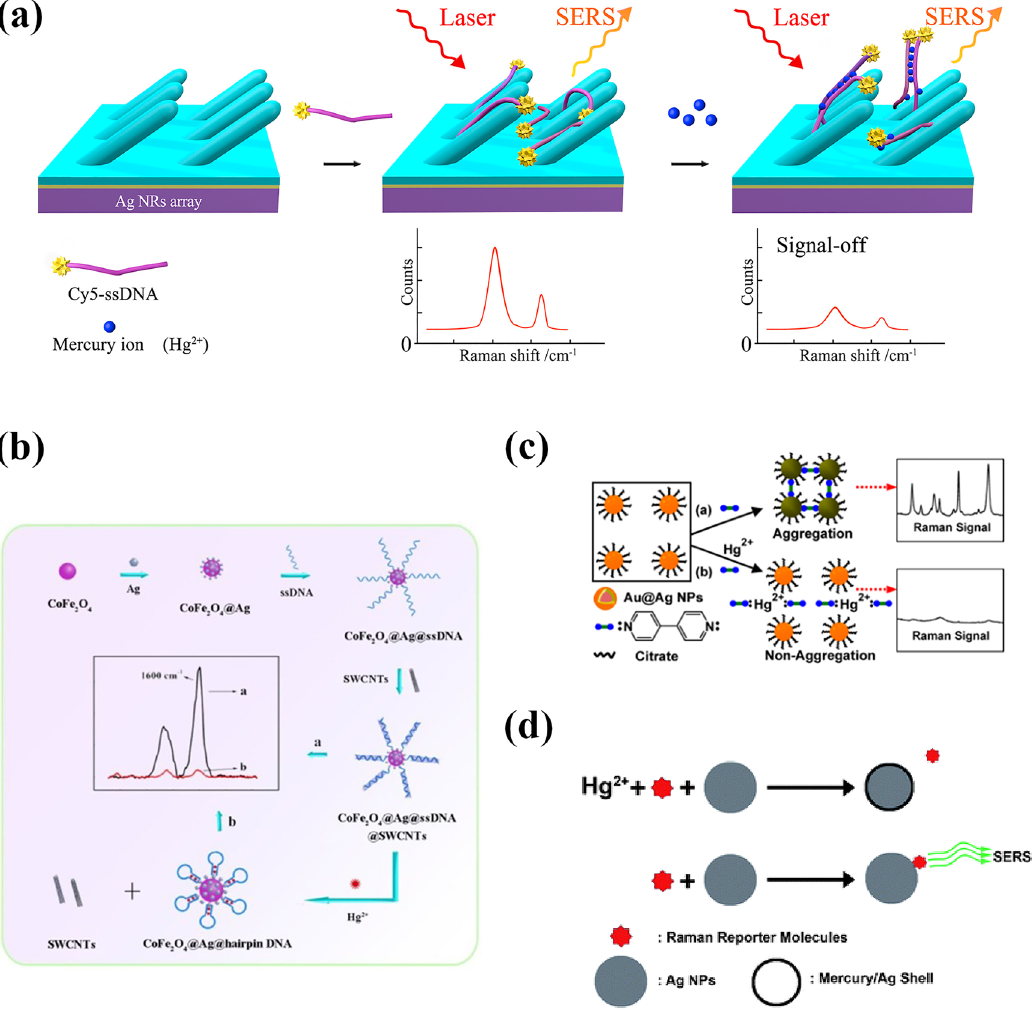
Figure 3: Schematic description of the detection of Hg 2 + ions based on “ turn-off ” mode. (a) Single-stranded oligonucleotides converted into double-stranded-like complexes with a vertical orientation [63]. (b) The SWCNTs stayed away from ssDNA because of the formation of the T – Hg 2 + – T structure [64]. (c) Dpy molecules were bound to Hg 2 + ions and released from the metal surface [65]. (d) Hg 2 + ions were reduced to zero-valent mercury and formed an amalgam